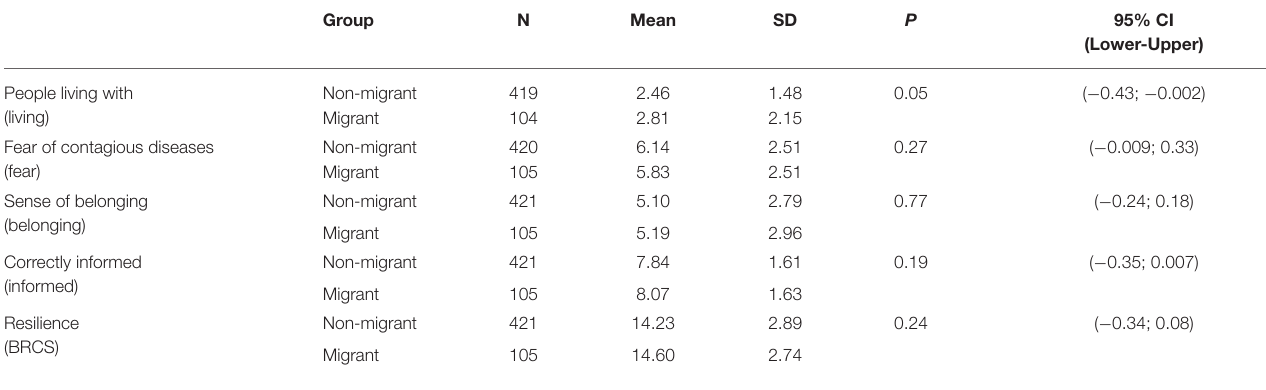
TABLE 1 | Descriptive analysis on the main variables of interest ( SD = standard deviation), and t -test for independent samples across groups.